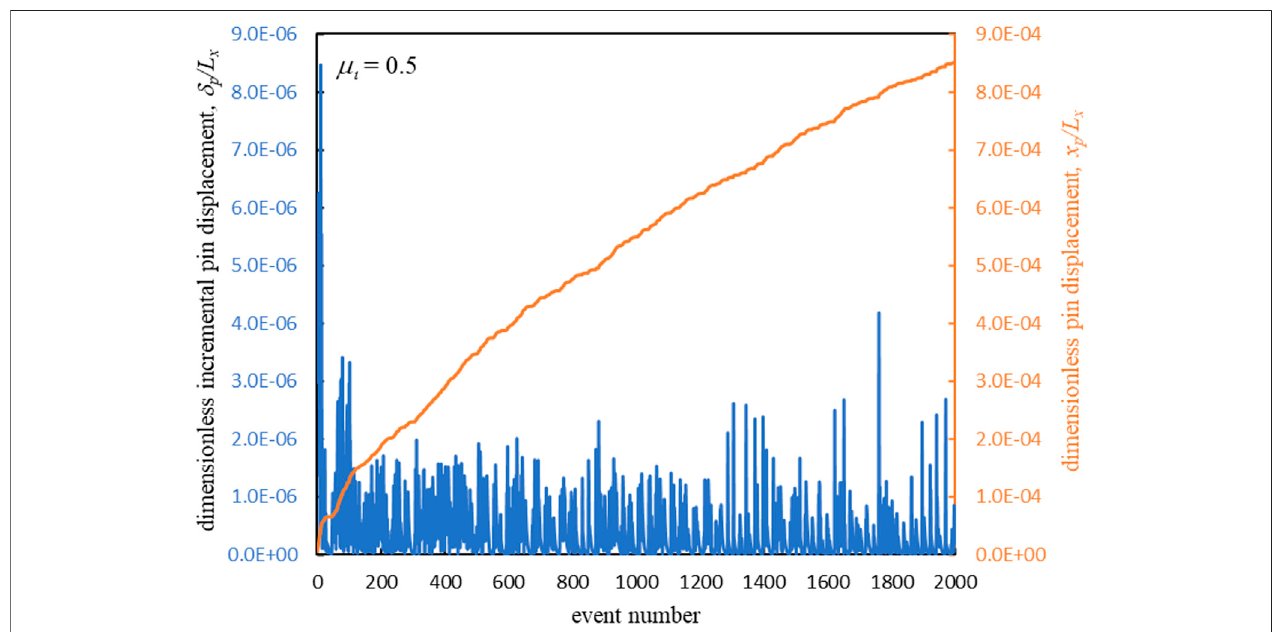
FIGURE7 | Incrementalandcumulativepindisplacementasafunctionofeventnumber.Aneventisde fi nedasaslip,releaseorre-establishmentofcontactatanode.